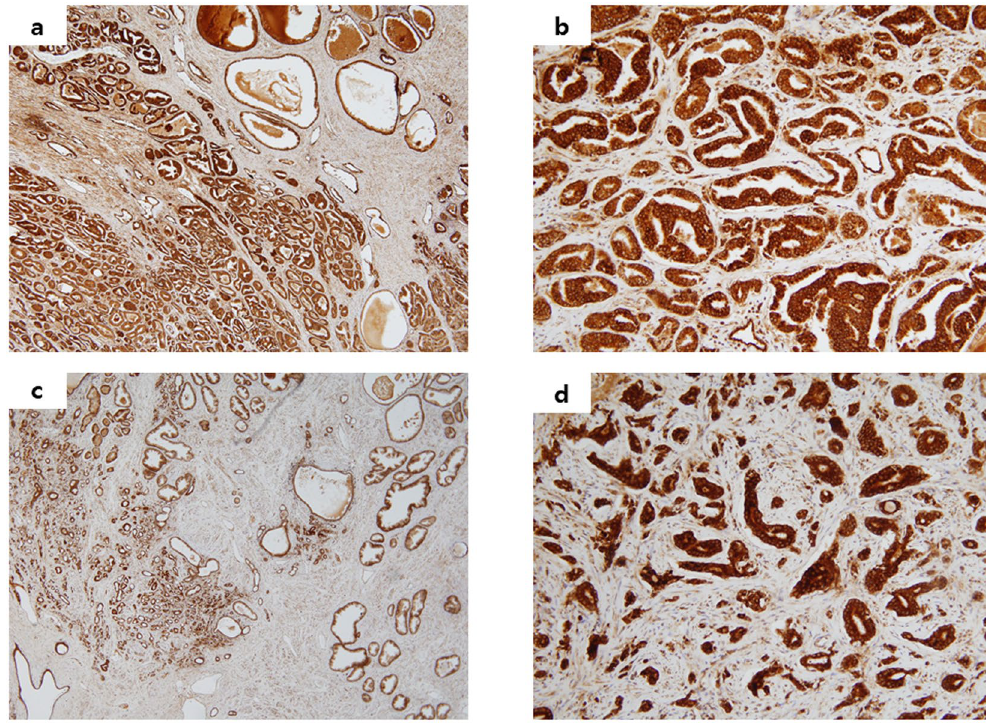
Figure 1. Representative photomicrographs of BMP-2 expression in malignant prostate tissue. ( a ) Normal BMP-2 expression in prostate cancer ( × 40). ( b ) Normal BMP-2 expression in prostate cancer ( × 200). ( c ) Decreased BMP-2 expression in prostate cancer ( × 40). ( d ) Decreased BMP-2 expression in prostate cancer ( ×